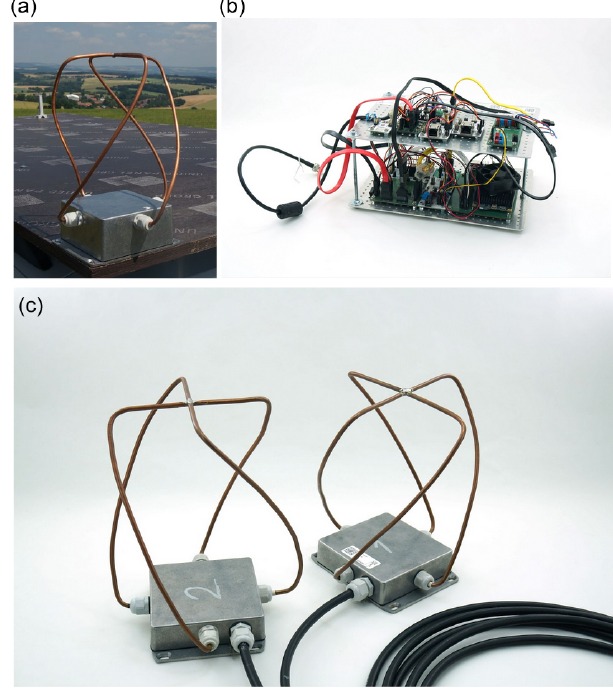
Figure 4. The platform of a QFH receiver antenna is shown in panel (a) . Detailed pictures of the antenna can be seen in panel (c) , and the receiver is shown in panel (b)